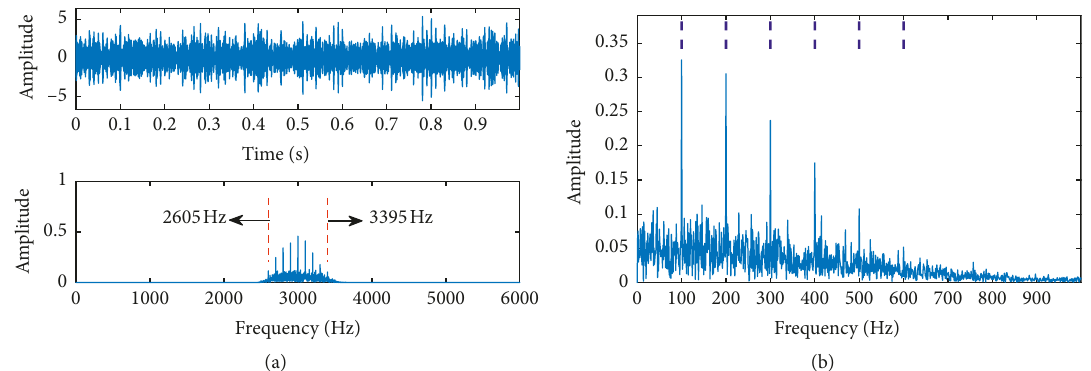
Figure 9: (a) Time-domain waveform diagram of the signal component with the maximum kurtosis found by the new method and its frequency band; (b)its envelope sequence.